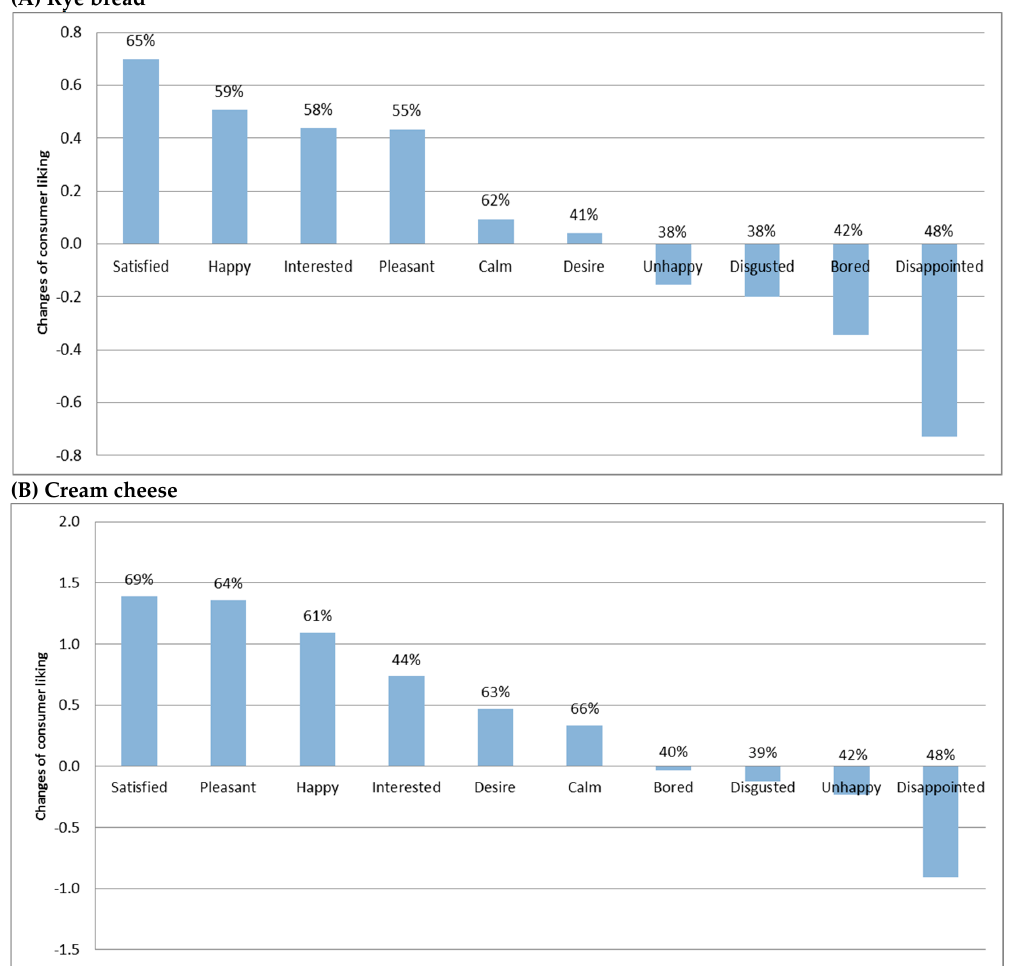
Figure 6. Penalty ‐ lift analysis of emotions’ effect on overall liking across ( A ) rye bread samples and ( B ) cheese samples. The frequency (%) of which the emotion descriptors were checked by consumers is also indicated. The values of the vertical axis indicate the unit of change in liking of prototypes for which the respective emotion attribute was checked, compared to liking of prototypes for which the emotion attribute was not checked. The upstand pillars represent the increase in consumer liking and the downward pillars indicate the decrease in consumer liking.